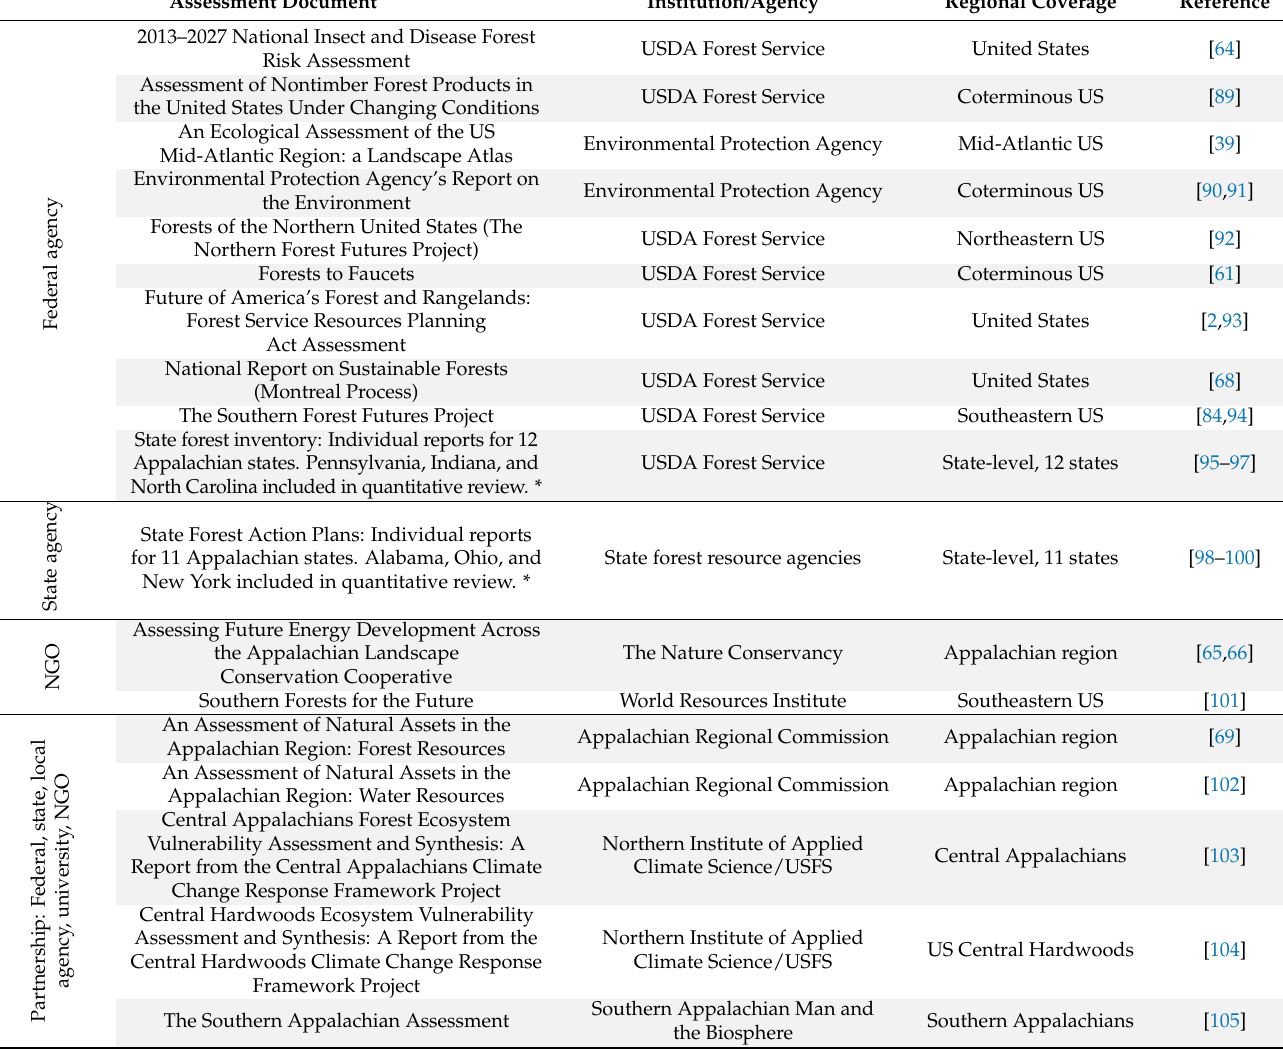
Table A1. Regional and national assessments with direct relevance to the provisioning of forest-based ecosystem services and their stressors, even if explicit ecosystem service language was not used in assessment documents. Assessments encompassed either the Appalachian Landscape Conservation Cooperative (ALCC) region, which included significant parts of 15 states in the eastern United States, or at least one state within the ALCC. * Reports were available for 12 (state forest inventories) and 11 (state forest action plans) states partially or wholly in the ALCC region. We selected three representative states within each of these two assessment groups to include in our quantitative review of ecosystem service and stressor analyses (Figure 2). This reduced bias towards the approaches taken in these assessments, which were similar but not identical across